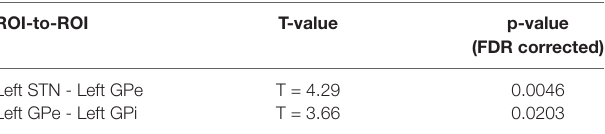
TABLE 2 | Significant results of ROI-to-ROI